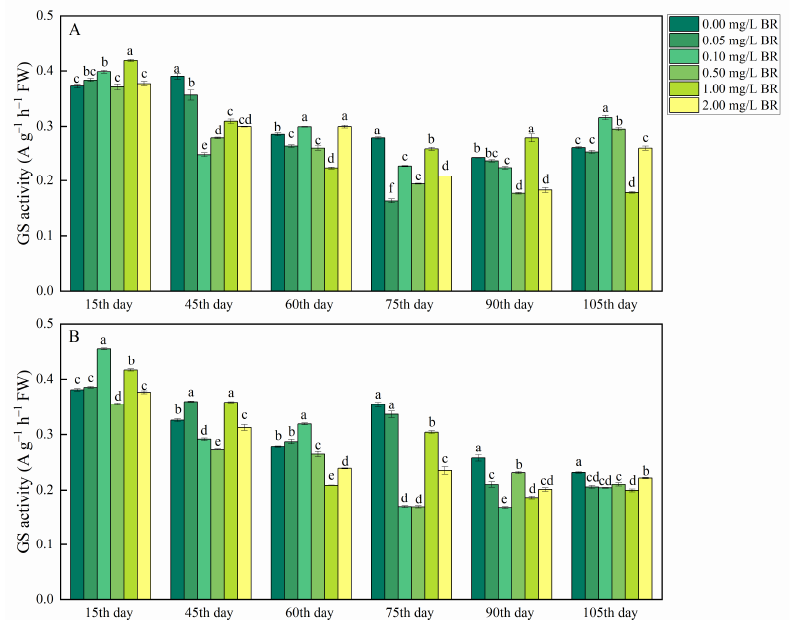
Figure 5. The change in GS activity in tubers ( A ) and bulbils ( B ) of P. ternata at different stages after BR treatments. The bars with different letters are significantly different from each other at the same stage after BR treatments ( p < 0.05). Values are means of four replicates ± SE.